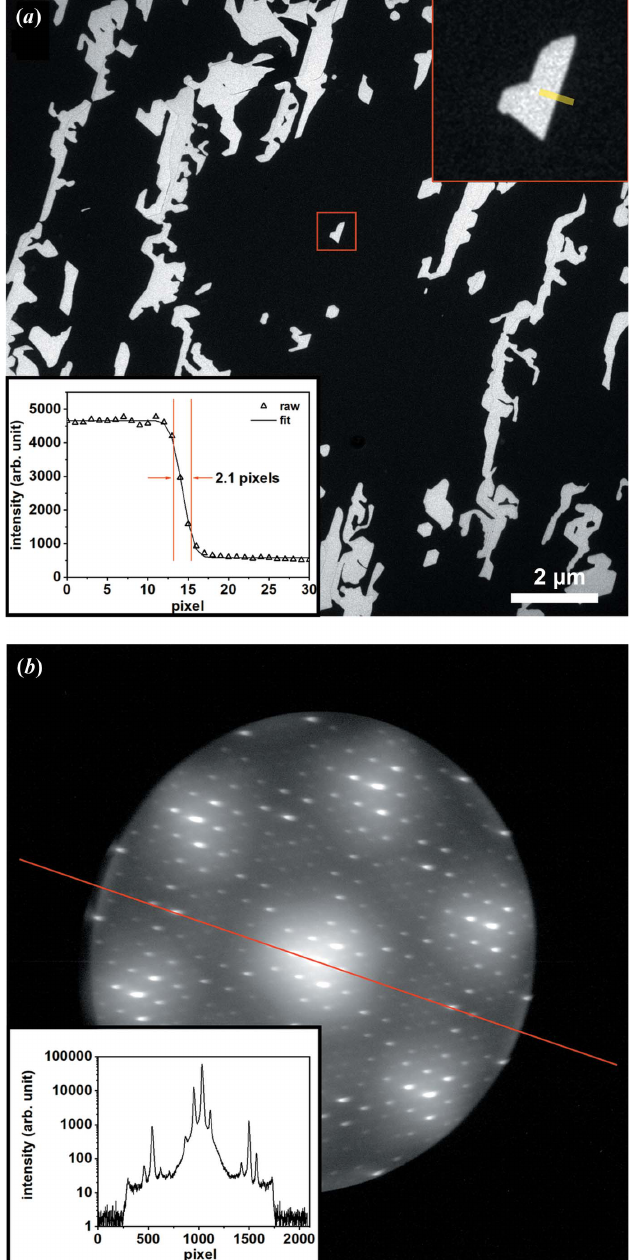
Figure 6 ( a ) LEEM and ( b ) micro-spot LEED images from an epitaxial mono-/ bi-layer graphene sample grown on SiC to show the resolution and dynamic range of TVIPS-F216. The image size of ( a ) is 20 m m (cid:6) 20 m m. The upper inset in ( a ) is the magnified image of the area selected in red (1484 nm (cid:6) 1484 nm) and the profile across the mono-/bi-layer boundary (yellow line) is shown in the lower inset of ( a ). The resolution of the detector is determined to be about 2.1 pixels, which corresponds to 32.8 nm. The inset in ( b ) shows the profile along the red line across the LEED spots [note that panel ( b ) is given on a logarithmic